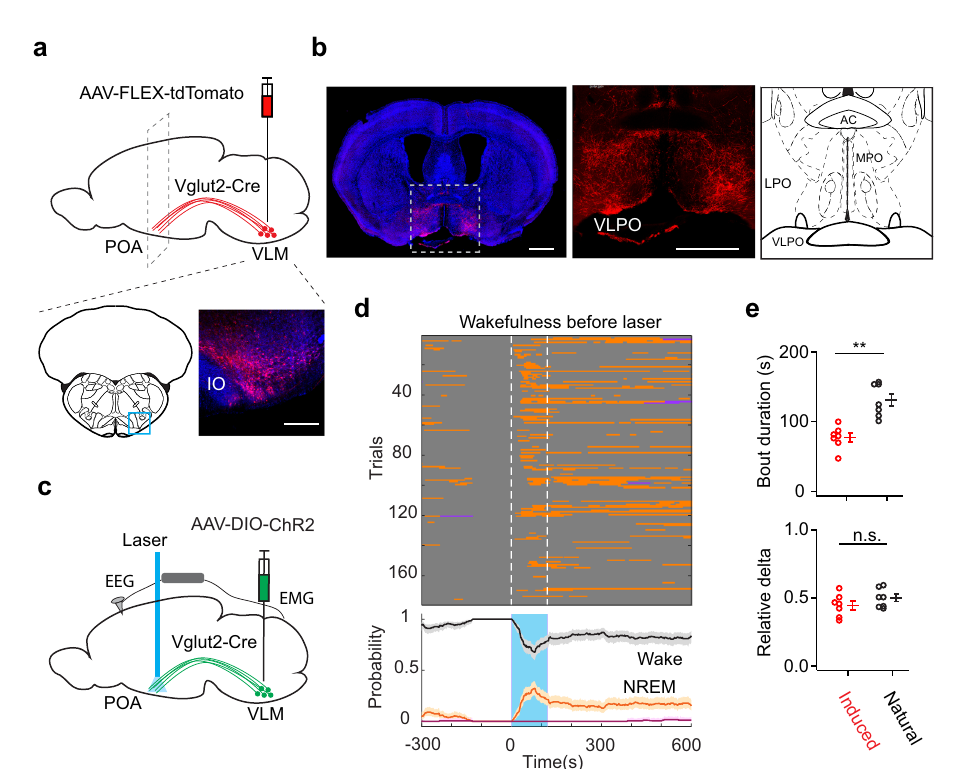
transition probability from wakefulness to NREM sleep induced by optogenetic activation ( n =14 animals for Vglut2-Cre with light, n =10 for Vglut2-Cre without light, n =5 for Vglut2-Cre/YFP, n =6 for Gad2-Cre, n =5 for CaMKII, Mann – Whitney U -test, ** P <0.0006 between Vglut2+light and control, P <0.008 between CaMKII andcontrol,controlreferstoVglut2nolight,Vglut2/YFP,andGad2+light, P =0.286 between Vglut2+light and CaMKII). Error bars, SEM. g Optogenetic stimulation of POA-projecting VLM neurons. Left upper, schematic of experimental design. AAVrg-Cre injected unilaterally in POA, AAV-DIO-ChR2-eYFP injected in VLM in wild-type mice. Left bottom, a trial of optogenetic activation (20Hz, 2min). Right, brain states and probability before, during, and after laser stimulation (66 trials from 3 mice). Traces in c , d , g are presented as mean ± 95% bootstrap con fi dence intervals. h Quantitation of wake – sleep transition probability under different fre- quenciesoflaserstimulation(2min, n =6Vglut2-Cremice).Errorbars,SEM.Source data are provided as a Source Data fi le.